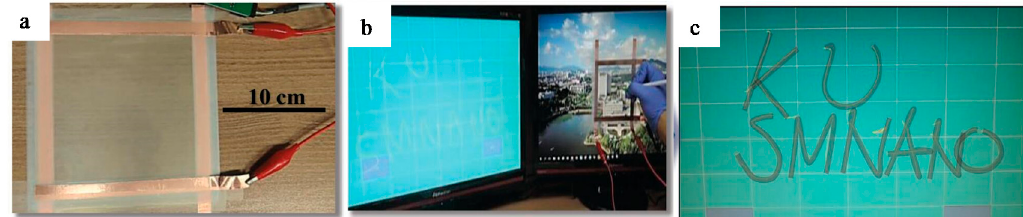
Figure 11. ( a ) AgNW-SiO 2 -based touch panel, ( b ) Writing on touch panel, ( c ) Letters written. Reprinted with permission from [106]; Copyright 2018 Wiley-VCH Verlag GmbH & Co. KGaA.